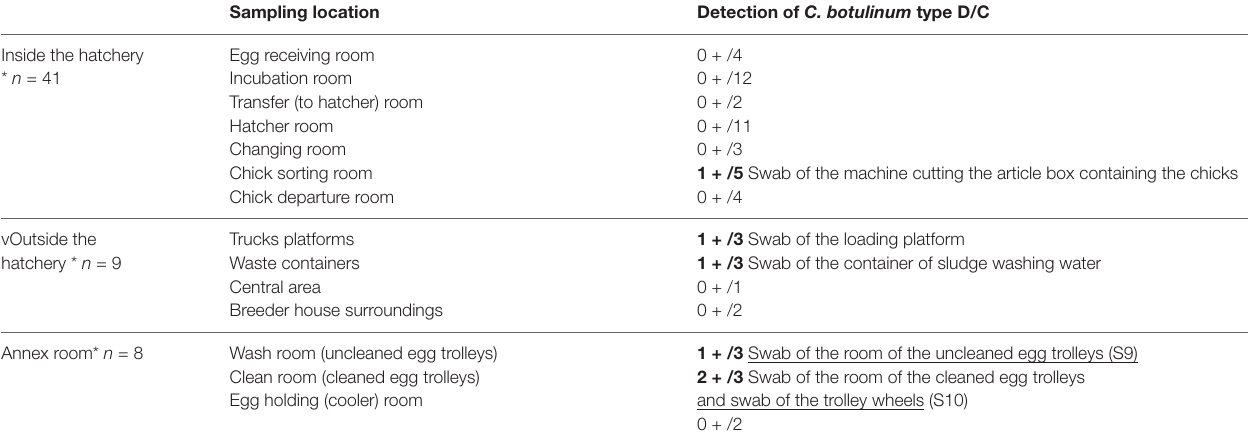
TABLE 3 | Detection of C. botulinum type D/C at the hatchery delivering chicks on the farm ( n = 58). Sampling location Detection of C. botulinum type